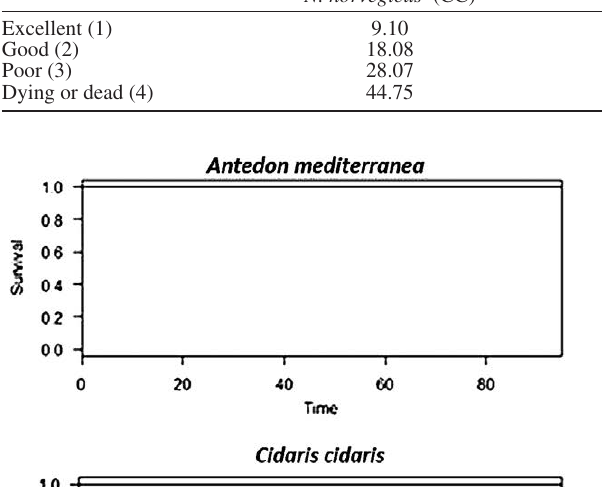
Fig. 3. – K-M model to assess the survival of Leptometra phalan- gium at vitality levels 1, 2 and